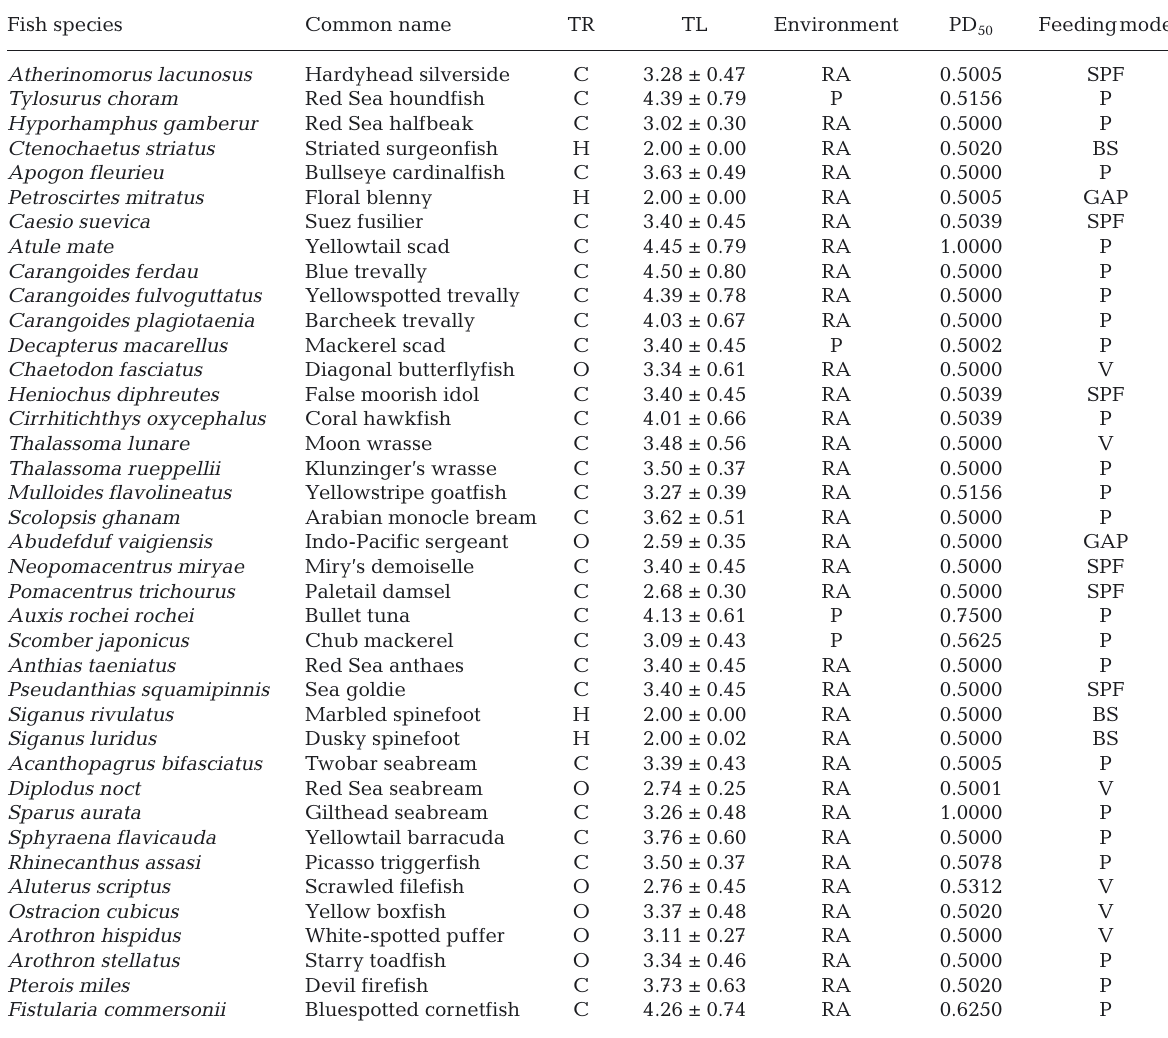
Table 3. List of fish species observed (listed in the same order as Table 2). Trophic tendency (TR; C = carnivore, H = herbivore, O = omnivore), trophic level (TL, mean ± SD), environment (P = pelagic, RA = reef-associated), phylogenetic diversity index (PD 50 ), and feeding mode (V = variable, SPF = selective plankton feeding, BS = browsing on substrate, GAP = grazing on aquatic plants), were taken from Froese & Pauly (2012). Note: all fish species are of commercial value, except Apogon fleurieu , Neopomacentrus miryae , and Arothron